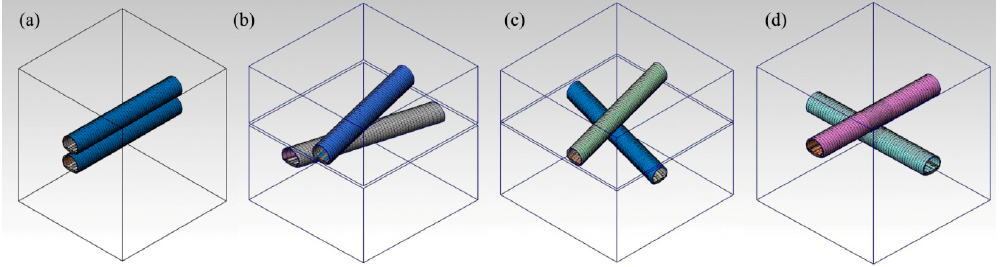
Figure 2. Numerical simulation model: the cross angle of two tunnels for ( a ), ( b ), ( c ), and ( d ) are 0°, 30°, 60°, and 90°, respectively.